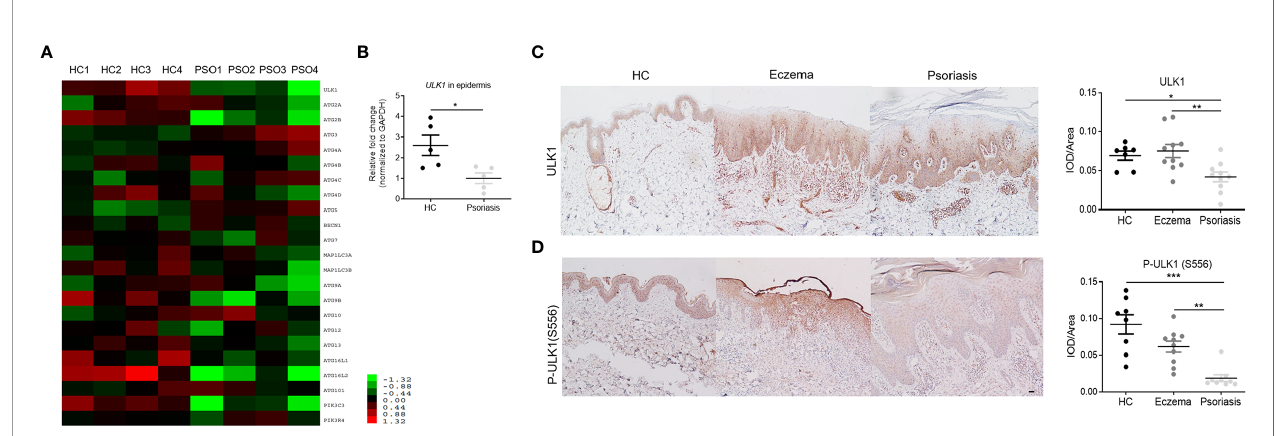
FIGURE 1 | Decreased expression of ULK1 in psoriatic epidermis. (A) Heatmap of the autophagy-related gene expression determined by microarray (n=4). (B) Expression of ULK1 mRNA (n=5) in epidermis from psoriatic lesions and normal skin from health controls (HC). (C, D) Representative image and quanti fi cation of ULK1 and phospho-ULK1 (Ser556) expression by immunohistochemical (IHC) staining in healthy control, lesional skin from patients with eczema or psoriasis (n=8-10). Scale bars, 50 m m. Data are presented as mean± SEM. *p < 0.05; **p < 0.01; ***p <